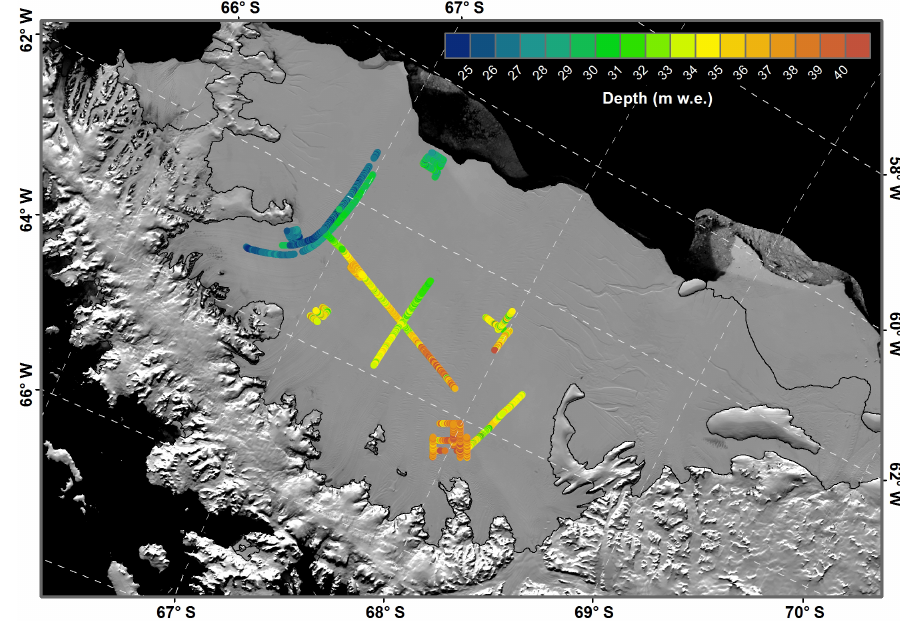
Figure 7. Map of the LCIS showing estimated total mass (mw.e.) above the strong, undated reflection horizon along the GPR tracks.